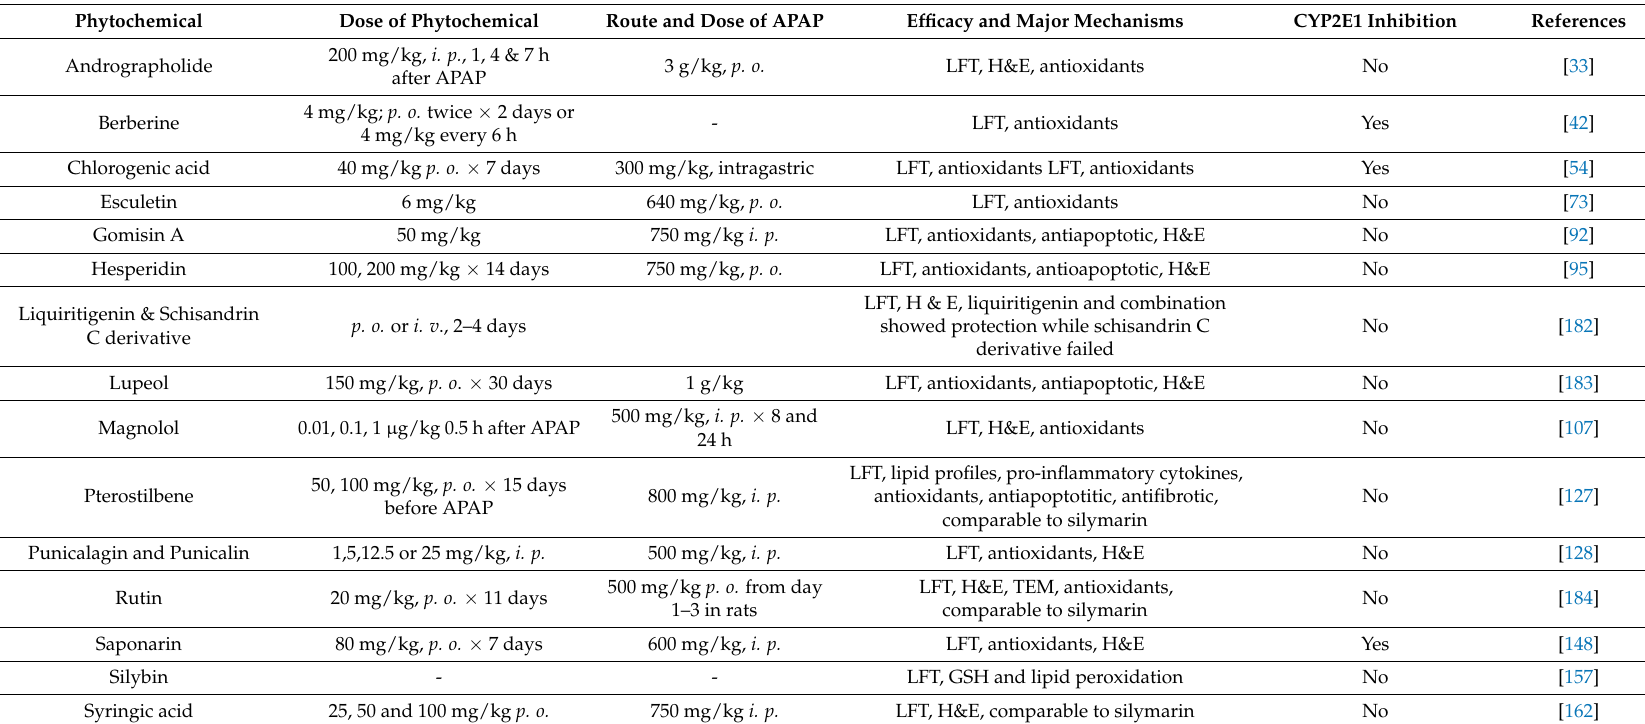
Table 2. Phytochemicals showed hepatoprotective effect in the rat model of acetaminophen-induced liver